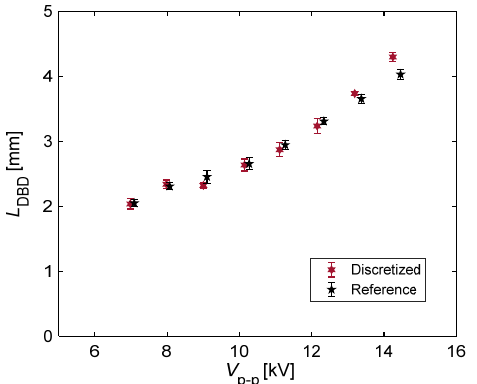
Figure 13. Plasma length ( L DBD ) estimated in section V as a function of V p-p for reference and discretized sheet-type PAs.